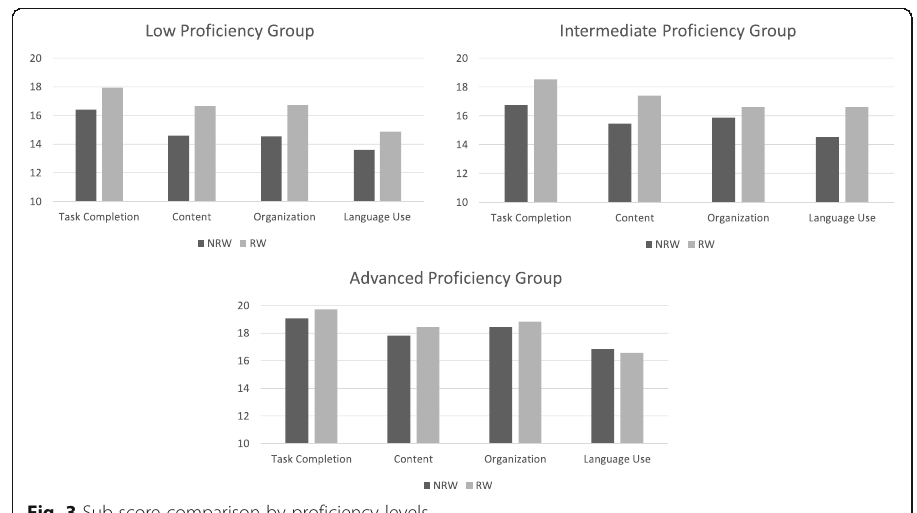
Fig. 3 Sub-score comparison by proficiency levels